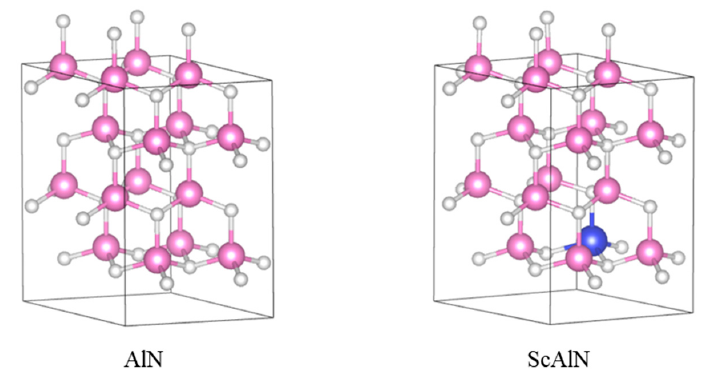
Micromachines 2023 , 14 , x FOR PEER REVIEW Figure 1. The wurtzite structure of AlN and ScAlN. Figure 1. The wurtzite structure of AlN and ScAlN.